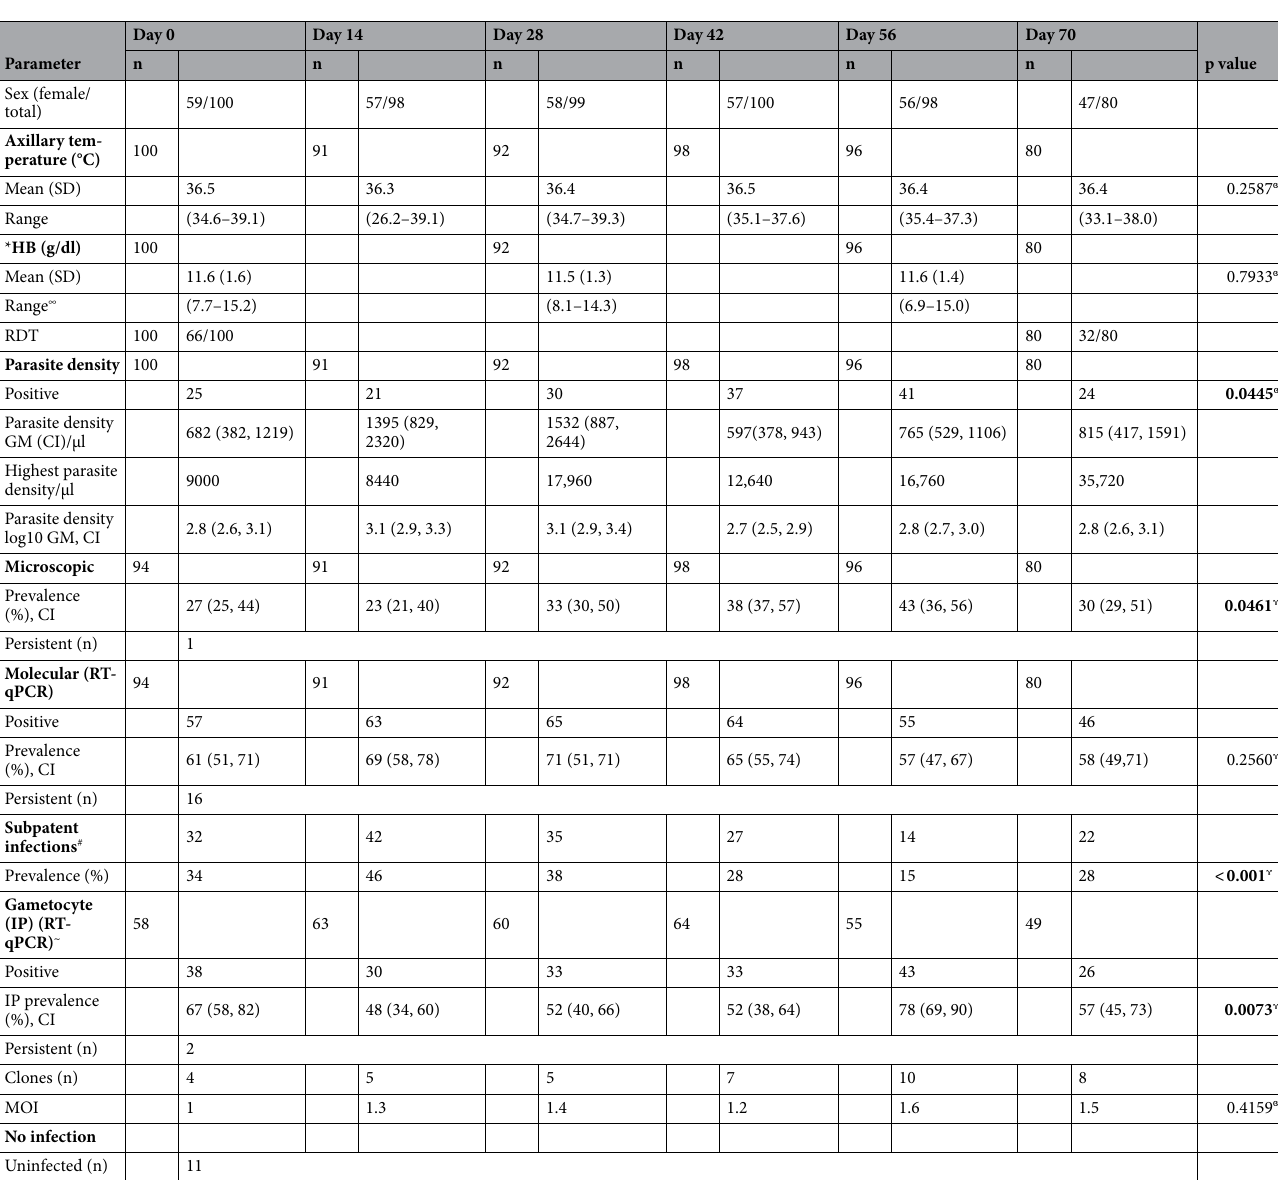
Table 1. Clinical characteristics of the population and infection dynamics during the sampling time points. n (number of samples), participants absent at a time point were not included. *Two participants have variant hemoglobin genotypes (SS and SC genotypes). ∞ Minimum recorded parasite density was set to 80 µl per whole blood. ~ Proportion of P. falciparum infections with gametocytes detected by molecular method. # Proportion of individuals with only submicroscopic parasites (the difference between the number of molecular and microscopic infections). IP infected population (only samples positive for 18S rRNA were evaluated for gametocytes). p values among time points were tested using one-way ɞ ANOVA and ɤ Chi-Squared. p values < 0.05 were considered significant as indicated in